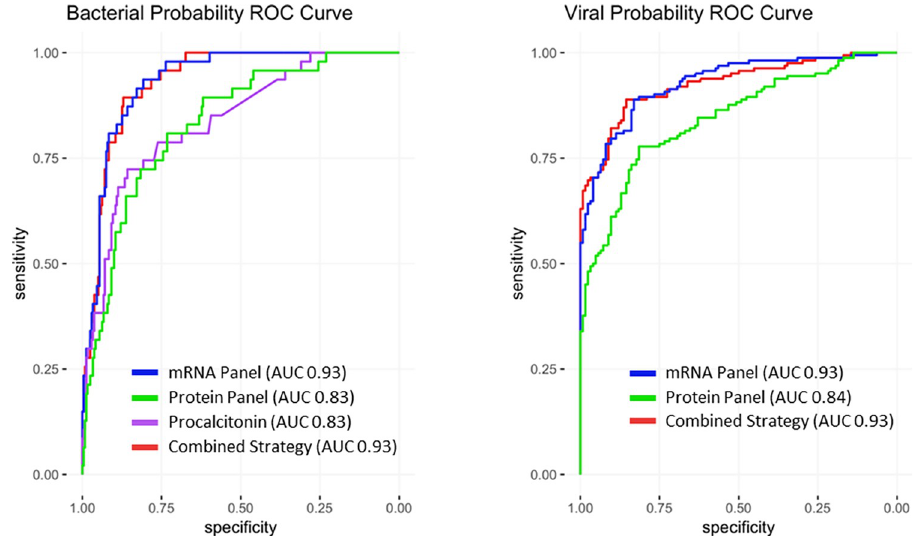
Fig 2. Bacterial and viral diagnosis receiver operating characteristic curves using different host biomarker strategies. Bacterial vs. non-bacterial classification is shown on the left. The combined strategy includes procalcitonin, protein panel, and mRNA panel. Viral vs. non-viral classification is shown on the right. For viral classification, the combined model includes the mRNA and protein panels.